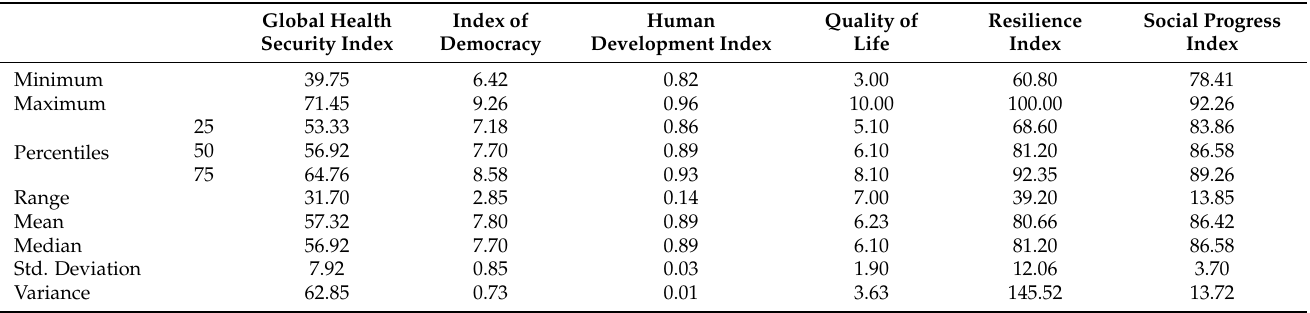
Table 2. Descriptive statistics for research variables. Average of the values 2020–2022 1